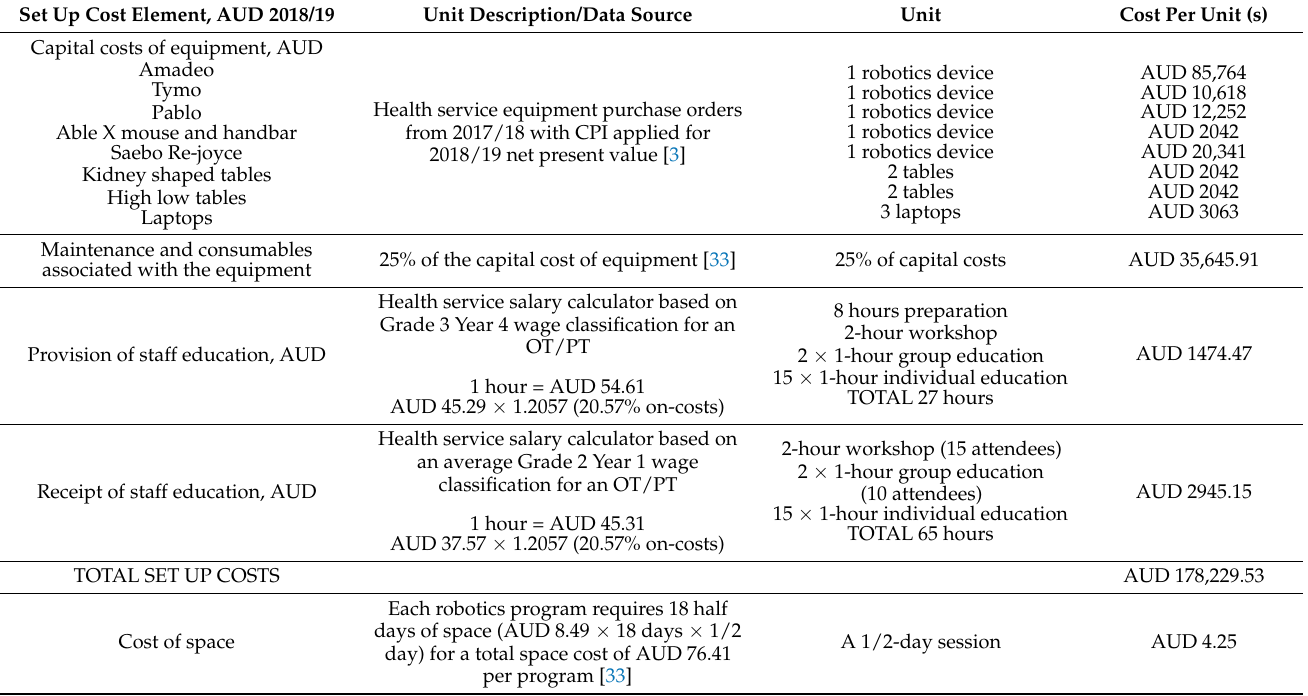
Table 3. Cost data—robotics program set up